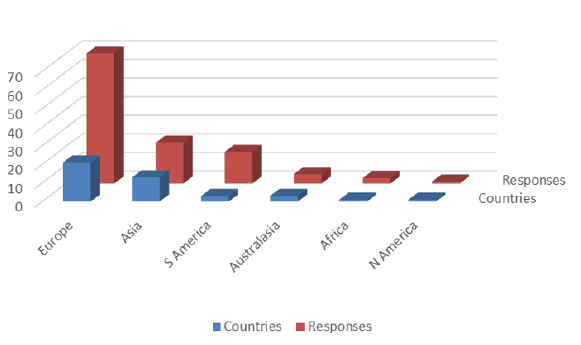
Figure 1. Summary of questionnaire responses by